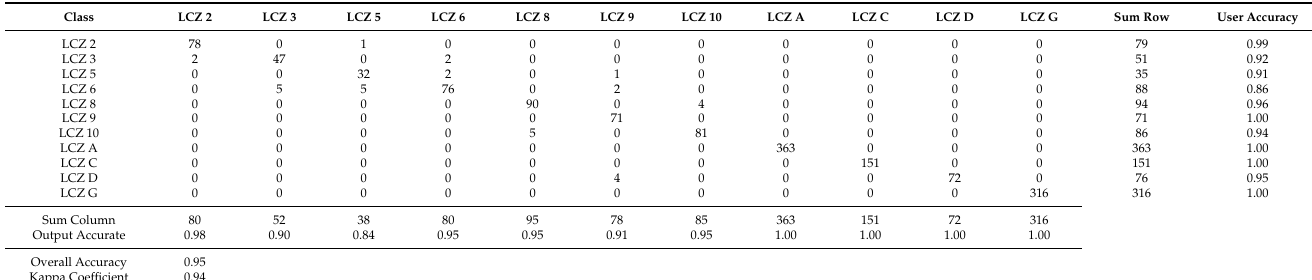
Table A2. Confusion matrix for the LCZ classification of Sendai, Japan in